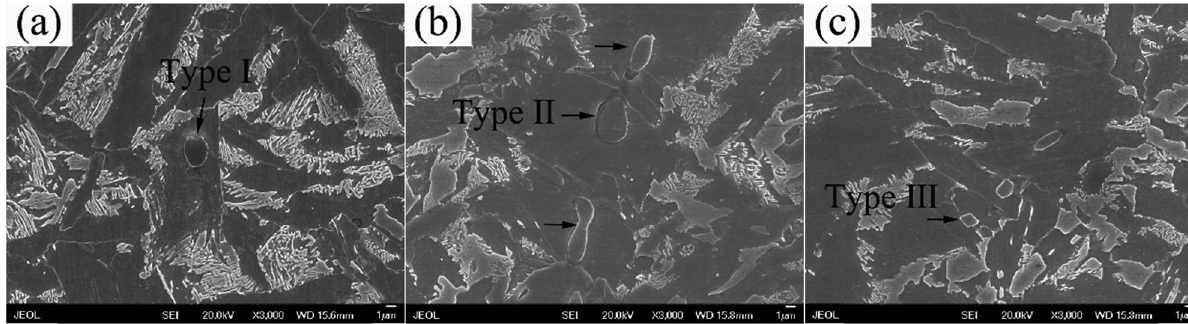
Figure 2: Morphology of MnS in as - cast steel ( a ) type I, ( b ) type II, ( c ) type III.